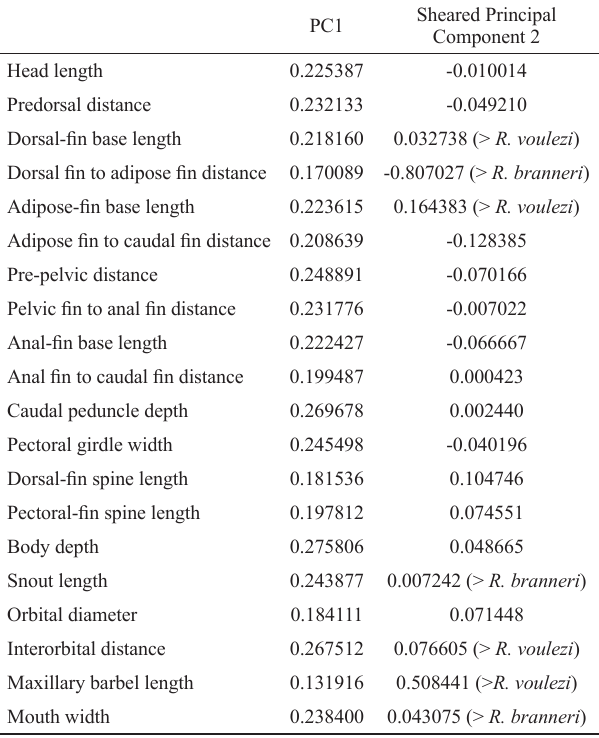
Table 4. Sheared principal component loadings of the principal component analysis of Rhamdia branneri (n=16) and R. voulezi (n=30).